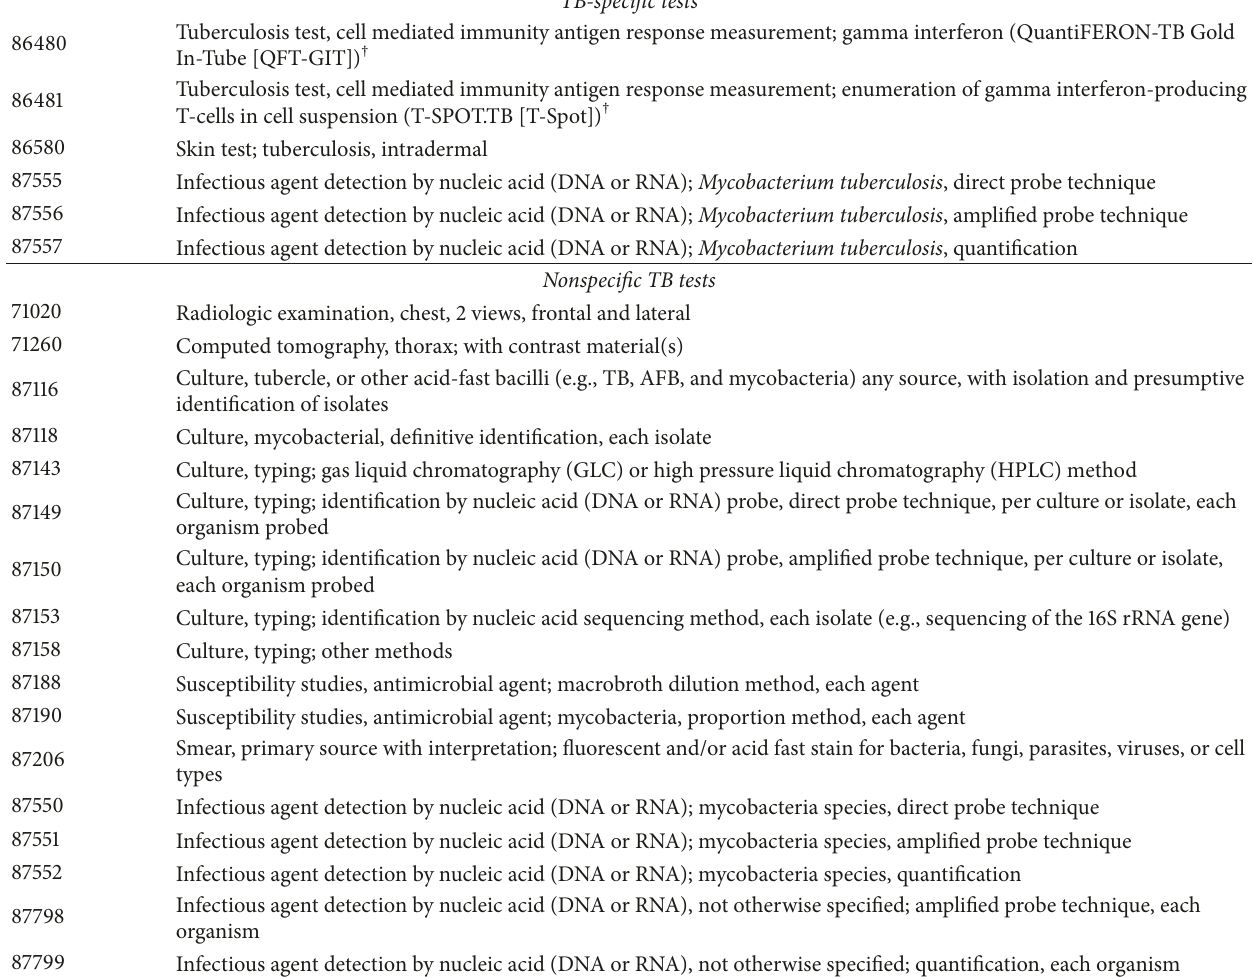
Table 1: Current procedural terminology (CPT) codes and their description for the TB-specific and the nonspecific TB tests. CPT